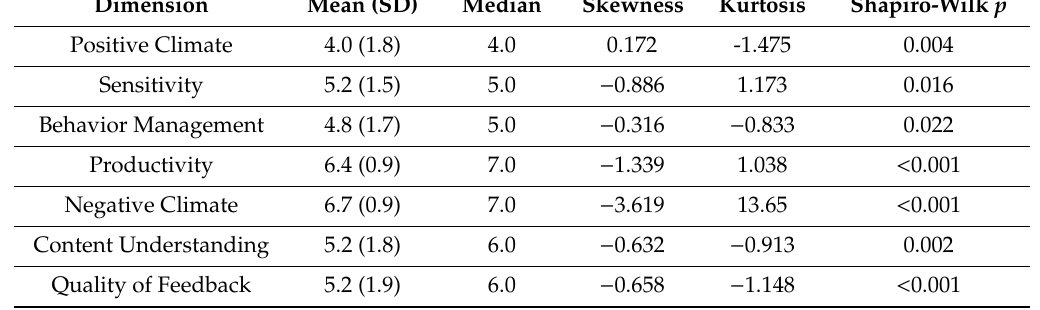
Table 3. Descriptive statistics and normality assessment for the ratings of quality of referee–player interactions for individual dimensions observed in soccer referees (n = 25).